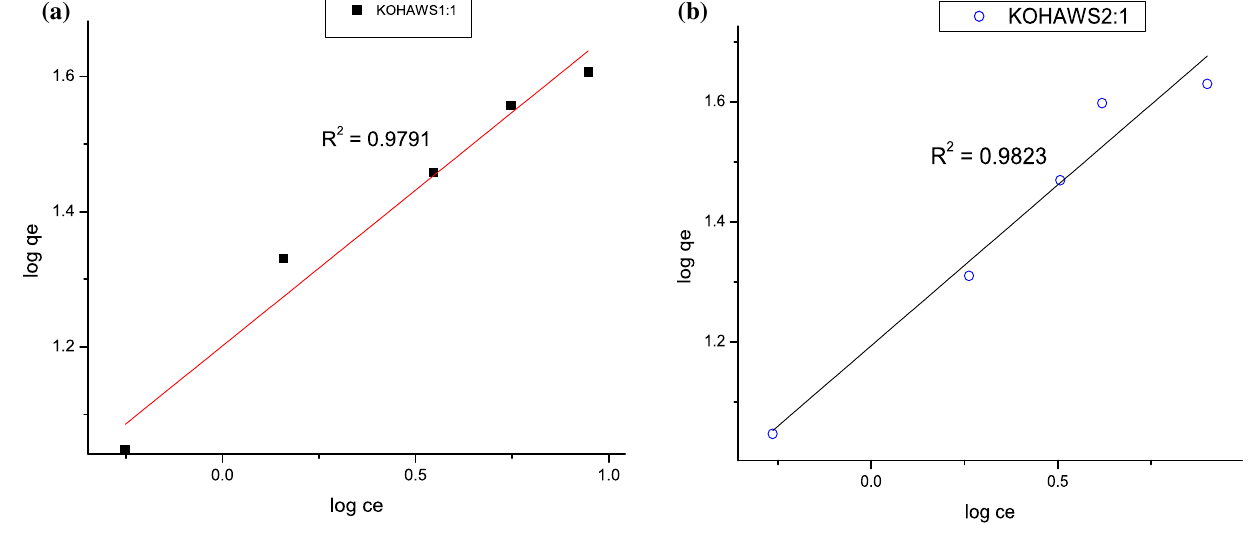
Fig. 11 Freundlich isotherm for a KOHAWS1 and b